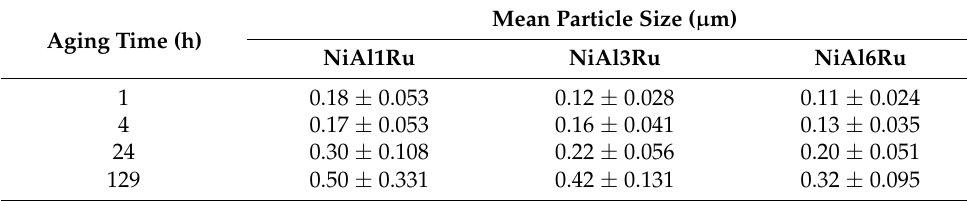
Table 2. Mean sizes of γ (cid:48) precipitates after aging treatment at 900 ◦ C over different times. Mean Particle Size ( µ m) Aging Time (h) NiAl1Ru